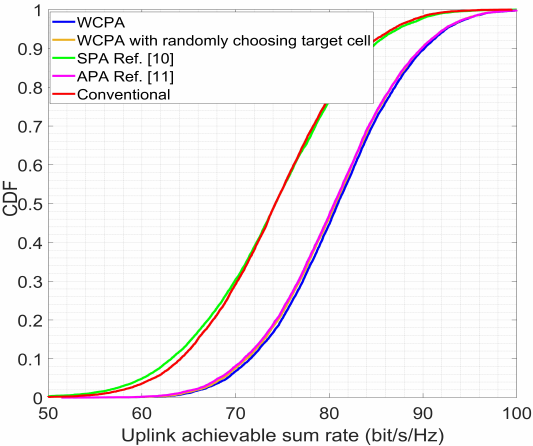
Figure 7. CDF of uplink achievable sum rate in case K = 8, S =